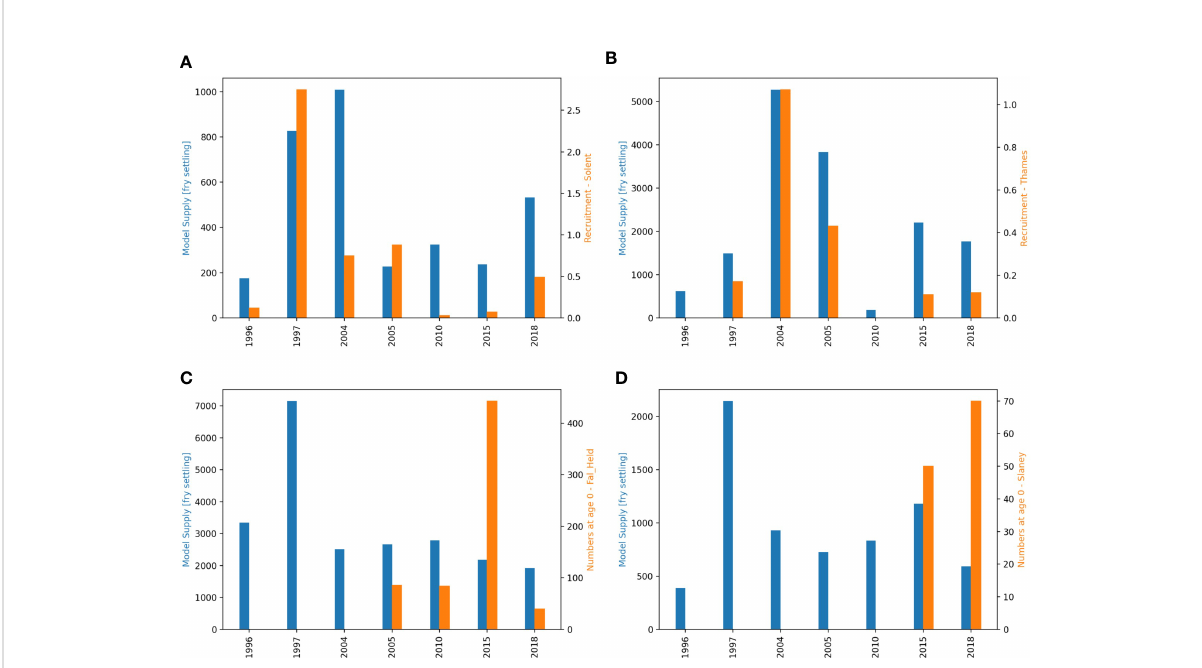
FIGURE 8 Comparison between model supply to nursery grounds and observed recruitment indices for each year of analysis, for (A) Solent, (B) Thames; or numbers at age 0 for (C) Fal, (D) Slaney. Recruitment indices are age aggregated and generated during analysis of the survey data (see Section